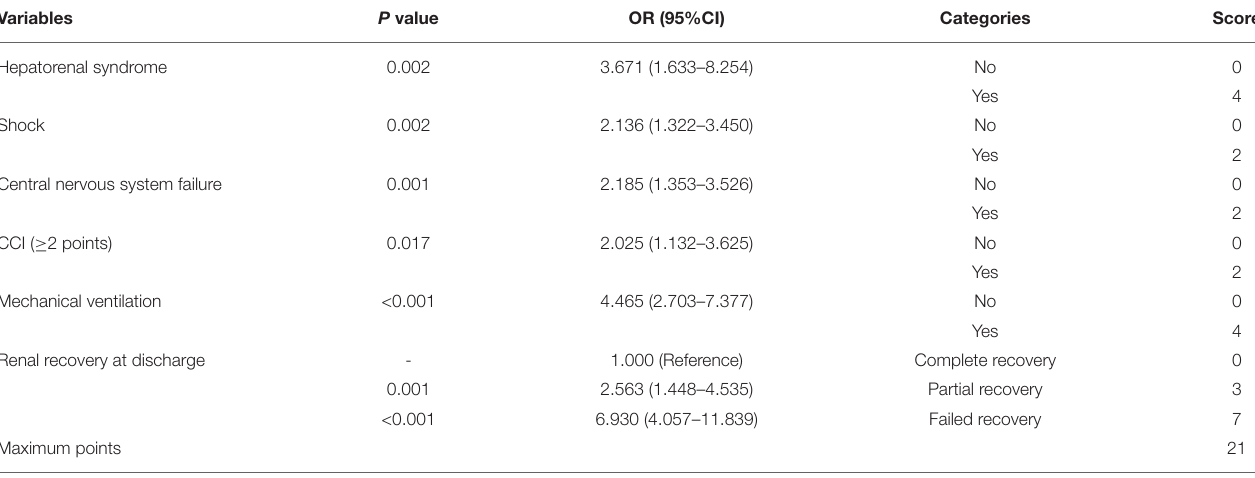
TABLE 3 | Predictors for 30-day mortality in the hospitalized ischemic AKI patients.